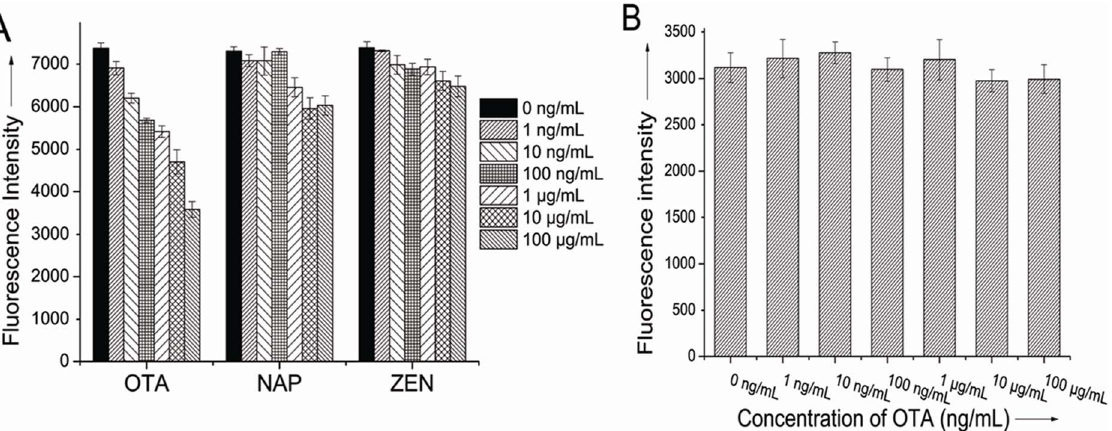
Figure 4. Selectivity evaluation the aptasensor for OTA. (A) Against NAP and ZEN in same series concentrations. (B) Using a chloramphenicol aptamer and its complementary